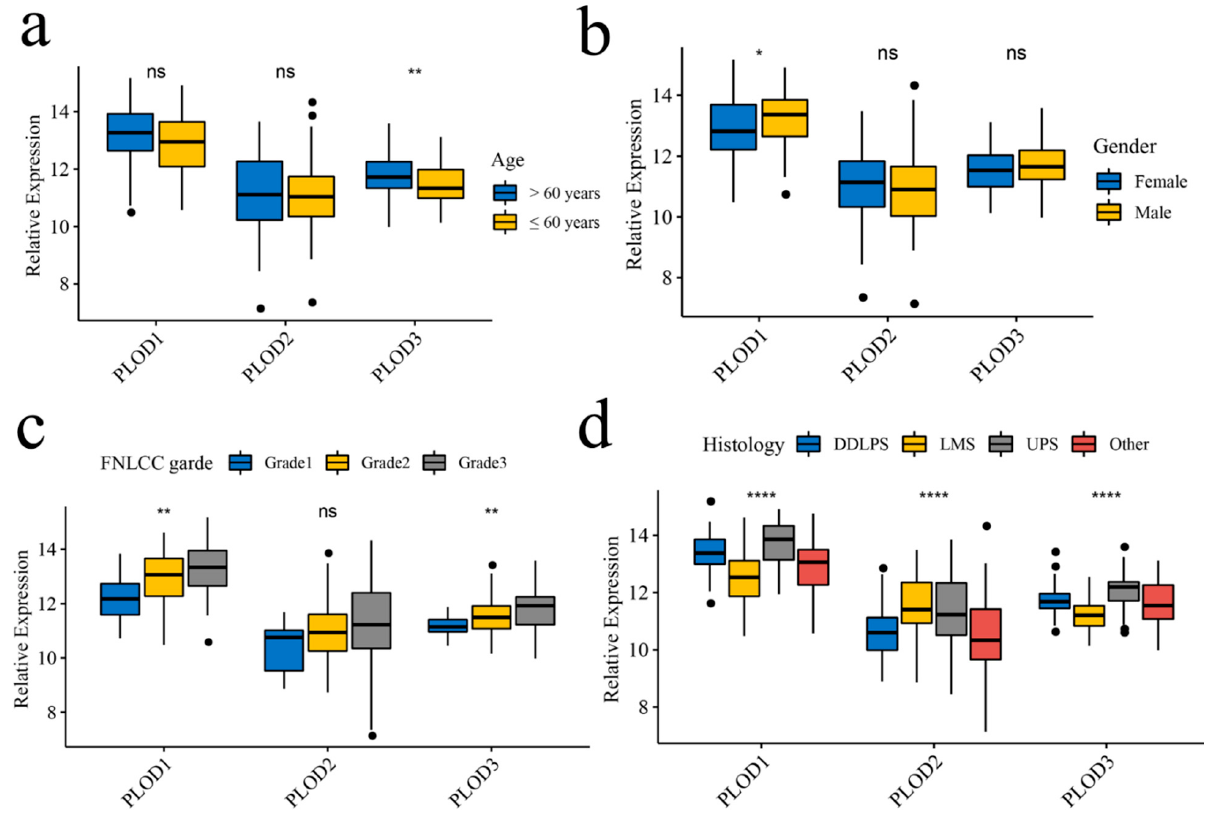
Figure 3. PLOD family members’ expressions in STS among age, gender, and grading/histology. ( a ) Age, ( b ) gender, ( c ) FNCLCC grades, ( d ) histology types. *: p < 0.05, **: p < 0.01, ****: p < 0.0001, ns: not